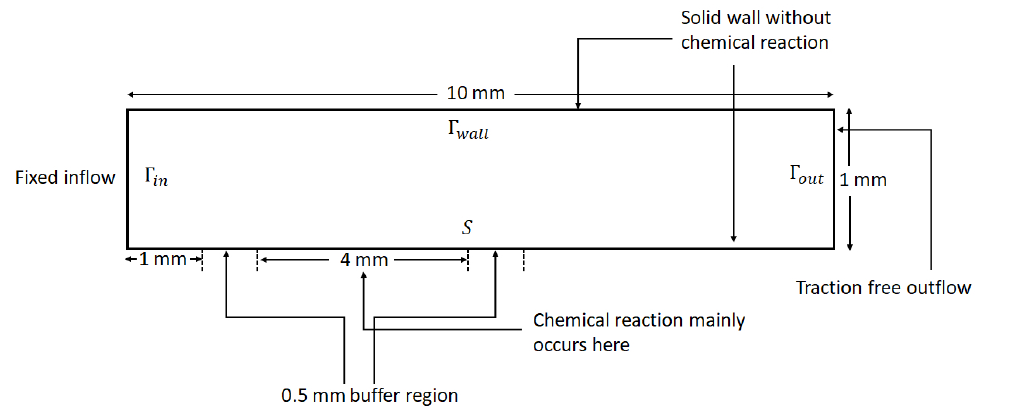
Figure 4. The computational domain Ω ( t ) for the test problem in Section 5.2 is initially a rectangle